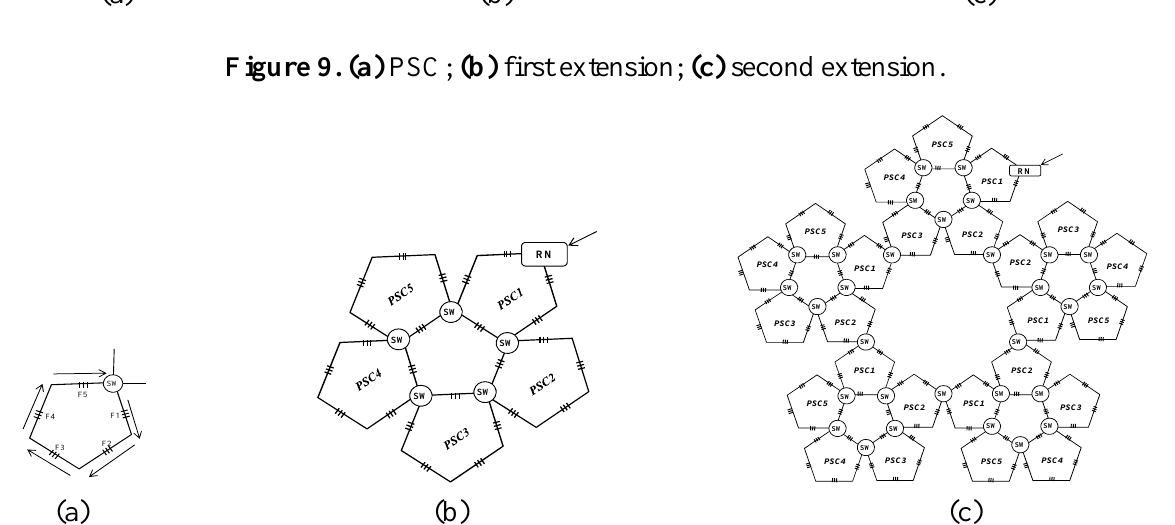
Figure 9. (a) PSC; (b) first extension; (c) second